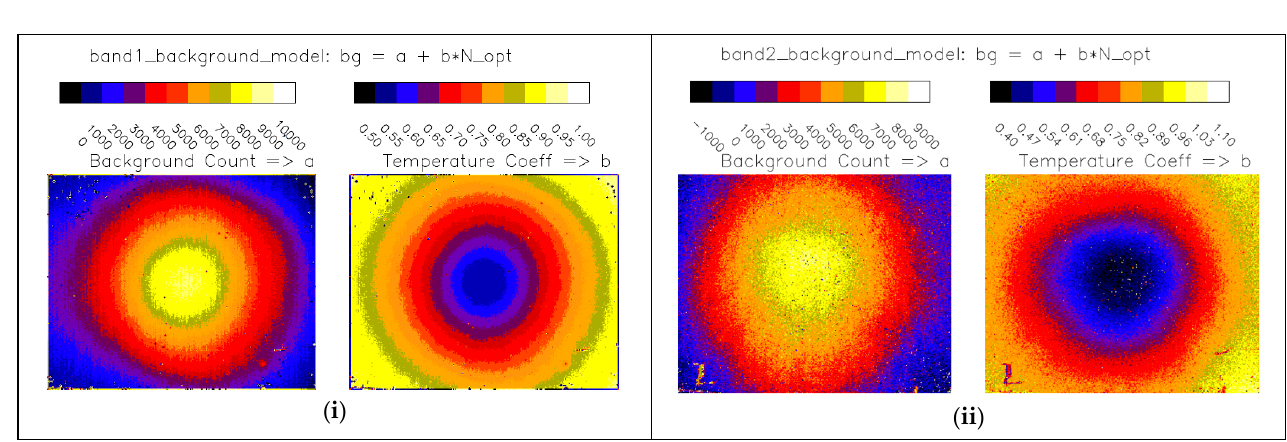
Figure A4. Derived coefficients a and b of the empirical background model in Equation (A2) for CTI band1 ( i ) and band2 ( ii ). Second, we smoothed the 𝑁(cid:3553) (cid:3042)(cid:3043)(cid:3047) variations along the orbital track to minimize effects